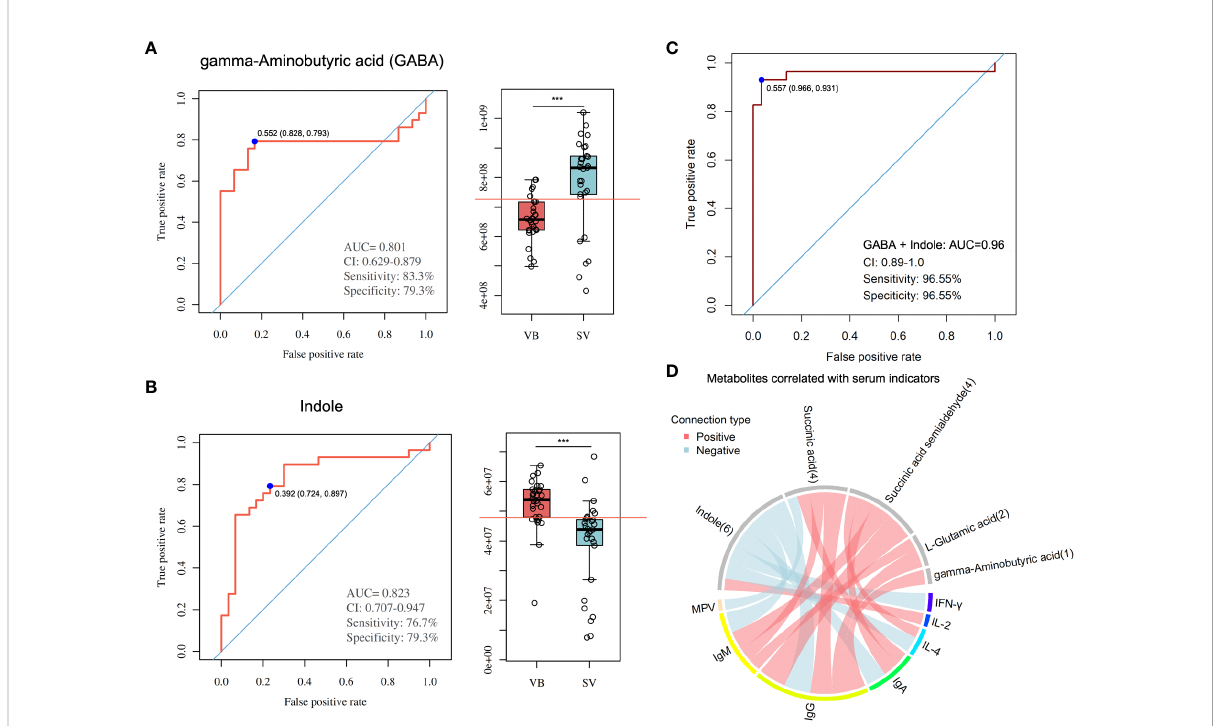
FIGURE 5 Metabolite markers for pairwise discrimination of the VB and SV groups. (A-B) Diagnostic accuracy of the single serum metabolite, GABA, and indole in distinguishing individuals that received two-dose vaccination in the SV group from the VB group. (C) The ROC curve with an increased AUC value based on the combination of GABA and indole. (D) Associations between serum metabolites and clinical parameters. The associated metabolites are colored gray, and the associated clinical parameters are colored successively. Each line indicates a signi fi cant correlation between a metabolite and a clinical parameter, with light red corresponding to a positive association (correlation coef fi cient ≥ 0.3) and light blue representing a negative association (correlation coef fi cient ≤